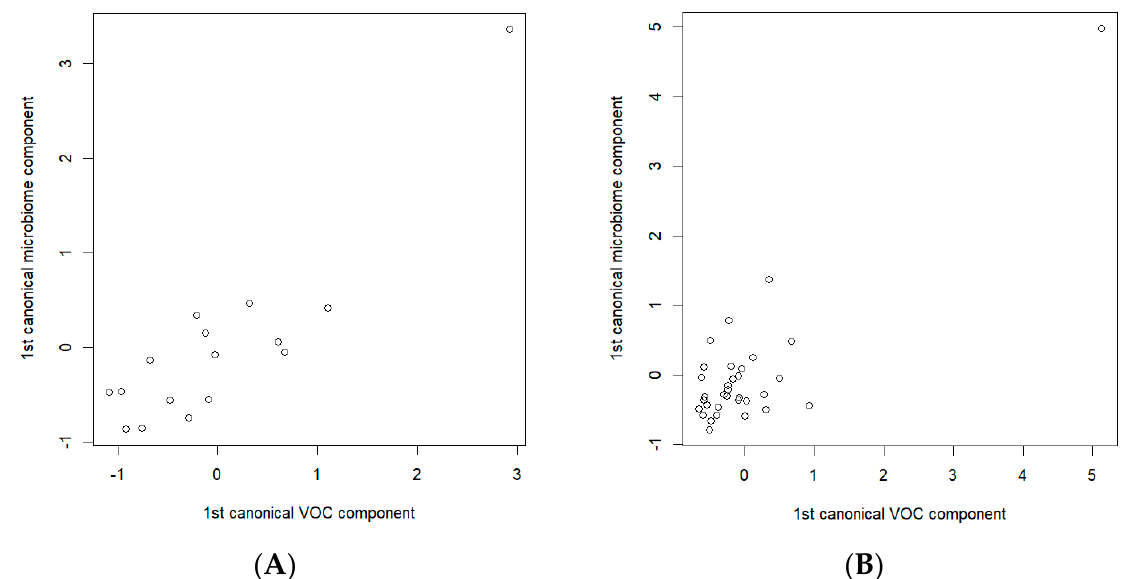
Figure 6. Canonical correlation score plot between the selected breath VOCs (the x -axis) and fecal microbiome composition (the y -axis) using the first canonical components for ( A ) cancer patients; ( B ) healthy controls. CCAs were performed on the sets of 14 and 7 breath VOCs, and 33 and 17 bacterial species, of the cancer patients and healthy controls, respectively.